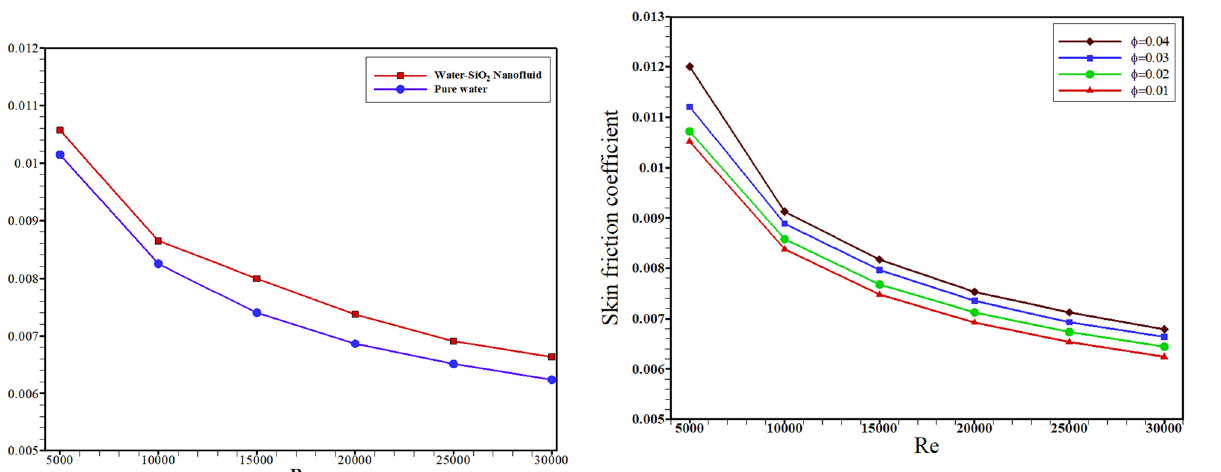
Figure 3: Reynolds number and skin friction coe ffi cient variation using water/SiO 2 nano fl uid and pure water for STC.